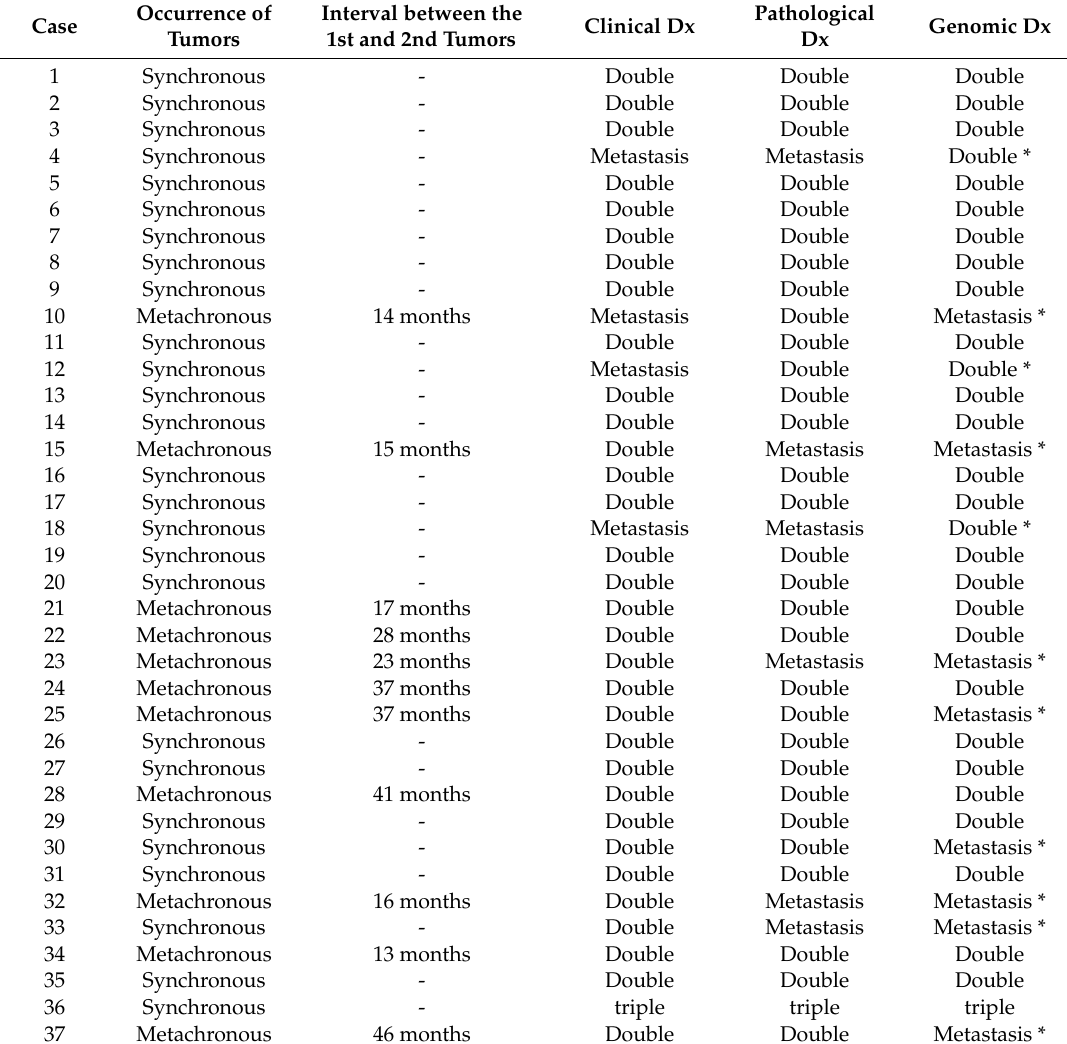
Table 1. Mutation analysis of the multiple lung